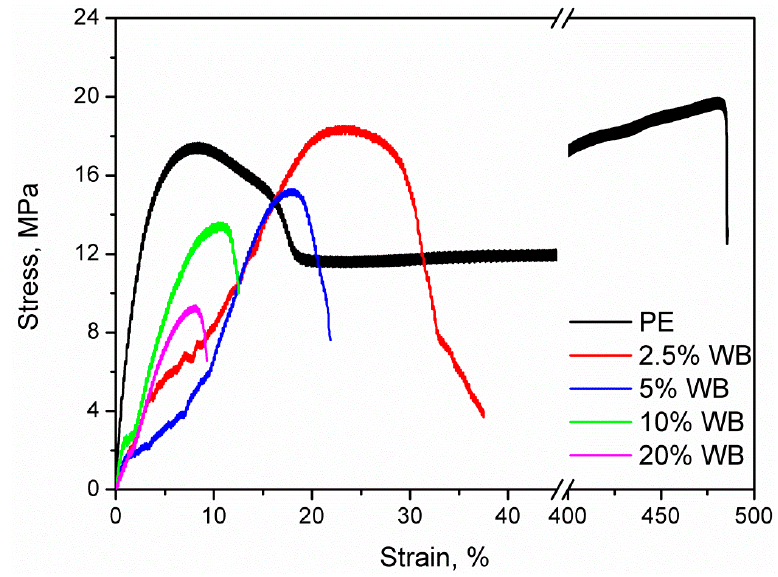
Figure 10. Exemplary stress-strain curves of prepared materials.